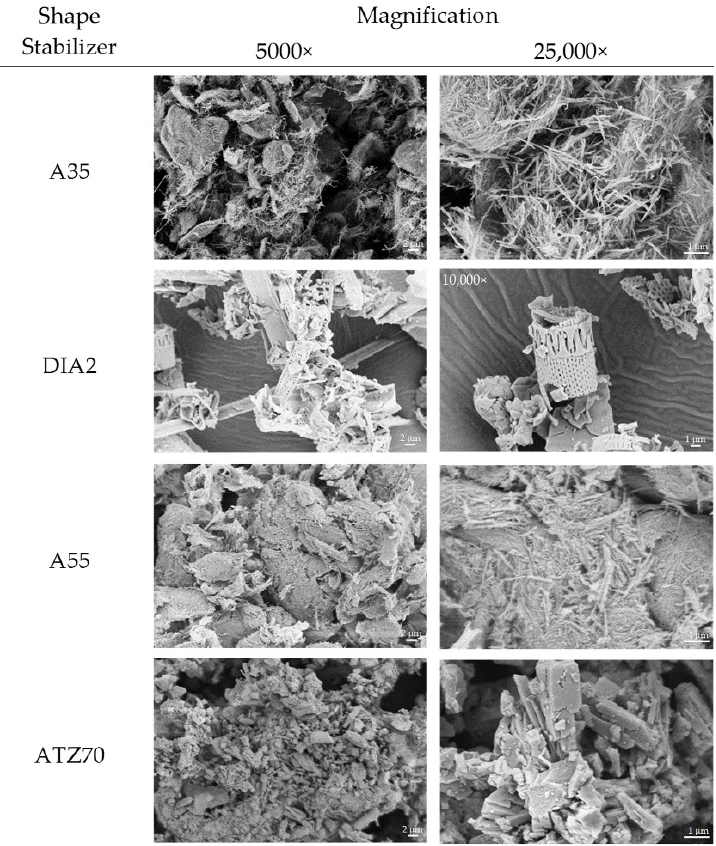
Figure 2. SEM micrographs of the porous media selected for the shape stabilization of the PCM.